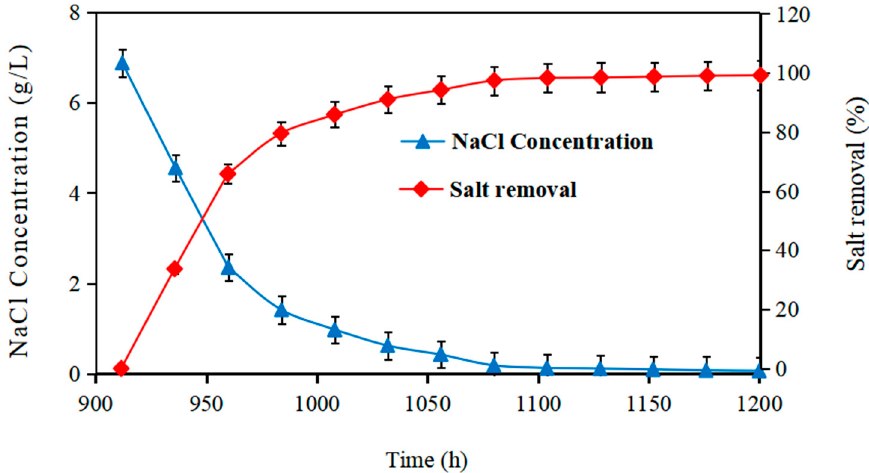
Figure 7. Salt removal versus time in the AMDC with coastal saline-alkaline soil-washing water.